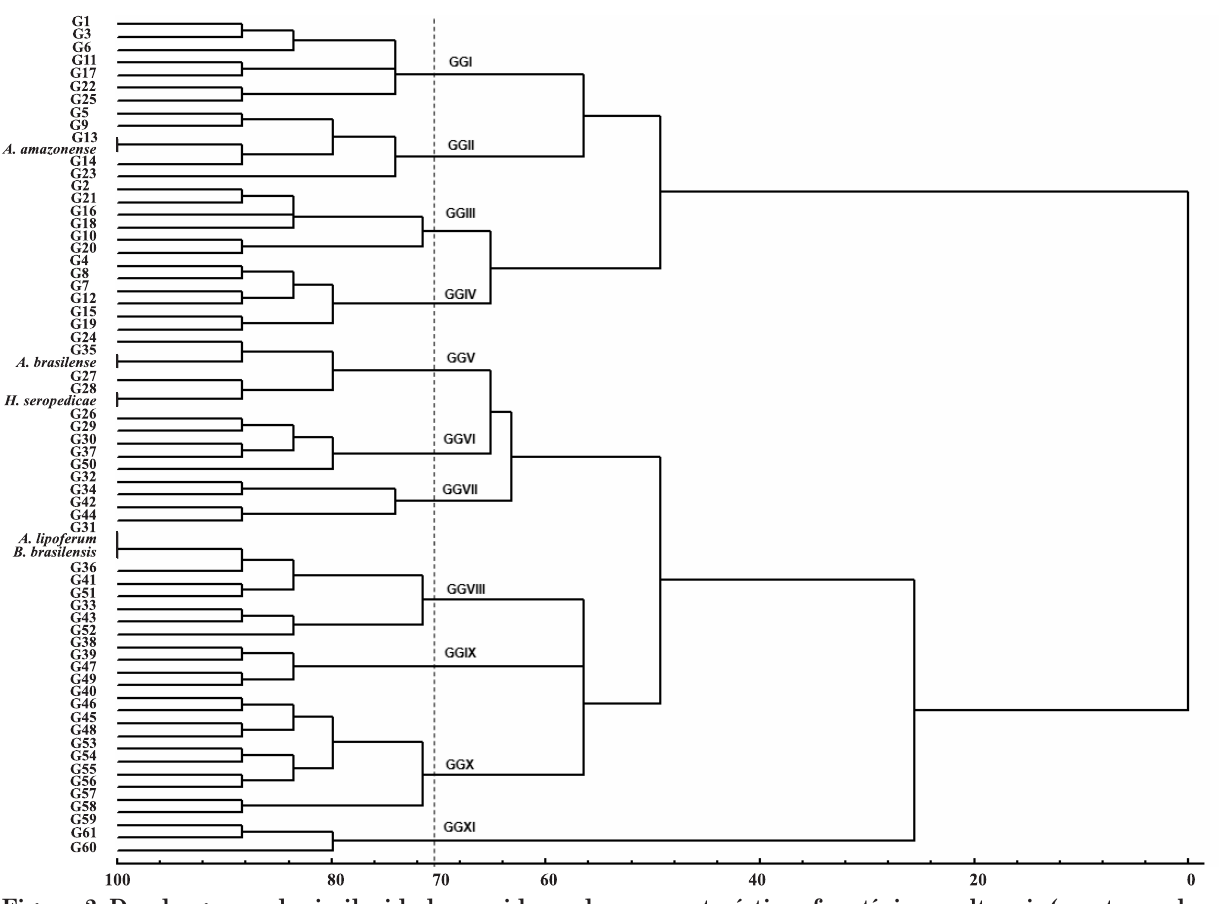
Figura 2. Dendrograma de similaridade considerando as características fenotípicas culturais (cor, tamanho e consistência de colônias) de isolados e estirpes-tipo de bactérias diazotróficas não simbióticas, para a coleta de